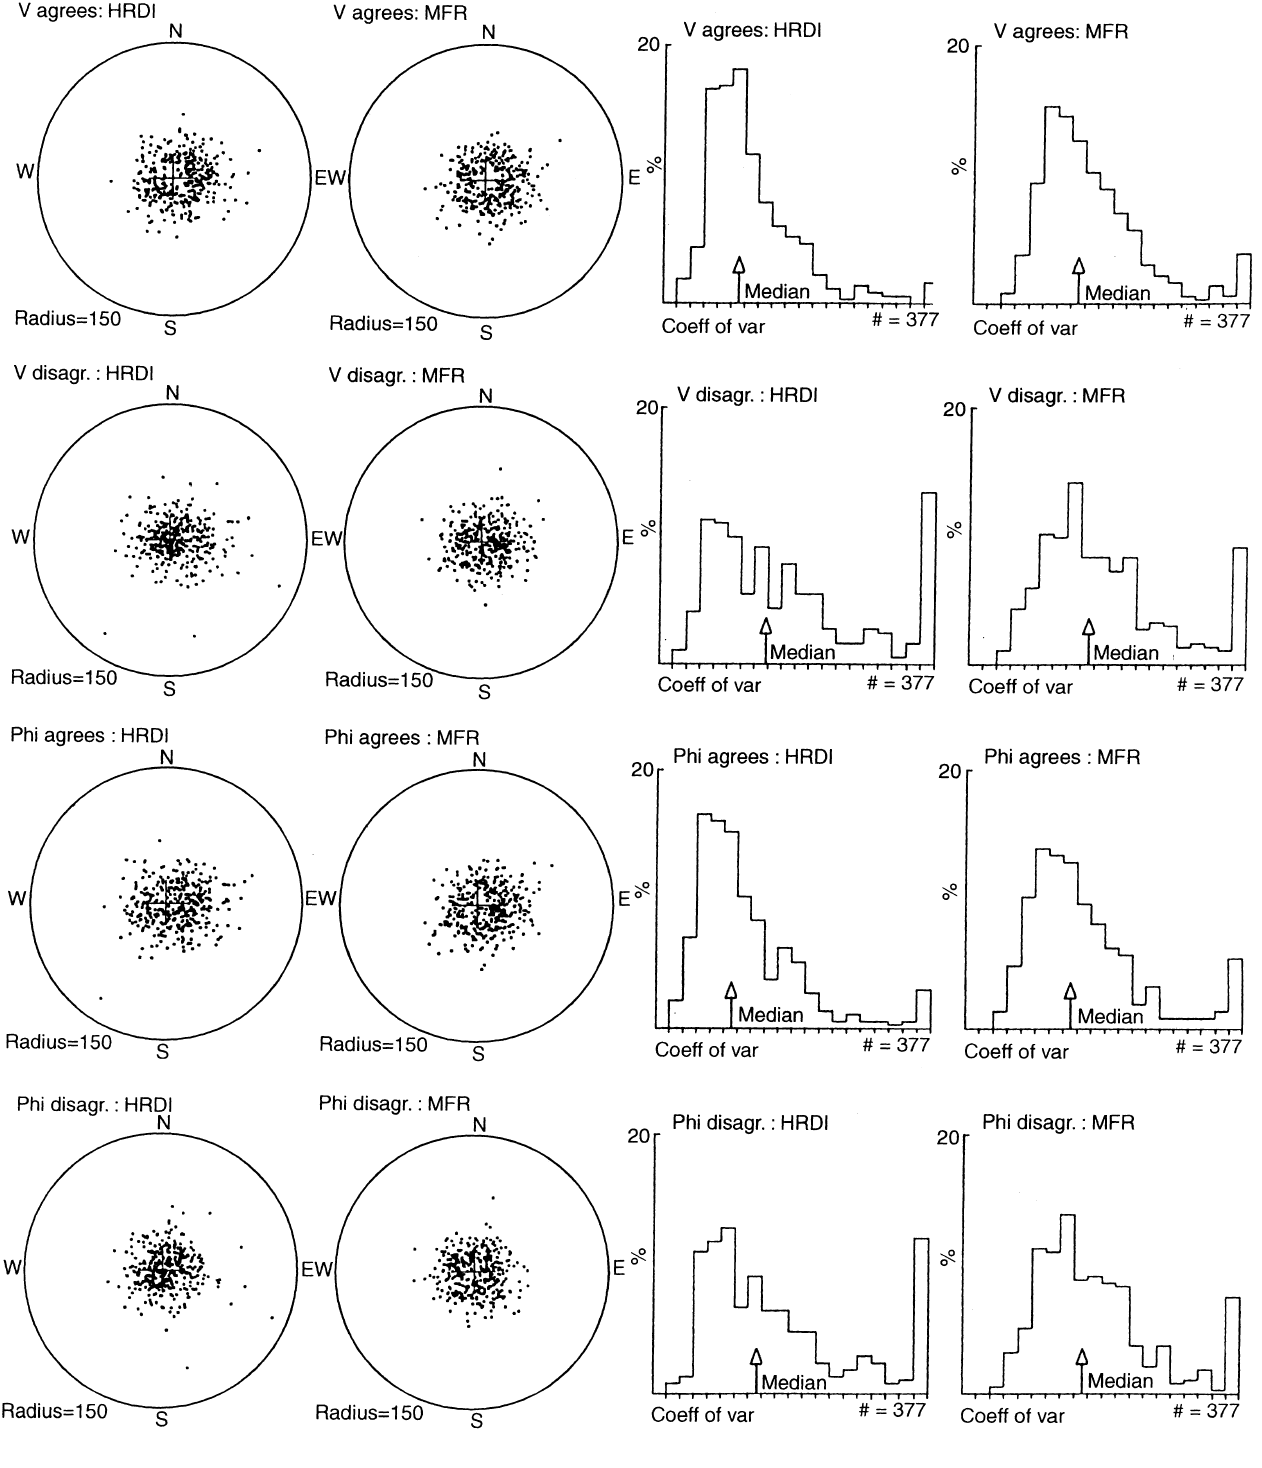
Fig. 10. Division of Saskatoon MFR and HRDI data (where HRDI wind vectors have been multiplied by 0.7) into two equal parts, agree and disagree , according to speed (top half of figure) and direction (bottom half). Left hand polar plots show wind vectors. Right hand histograms show relative internal errors. All data from 82–94 km